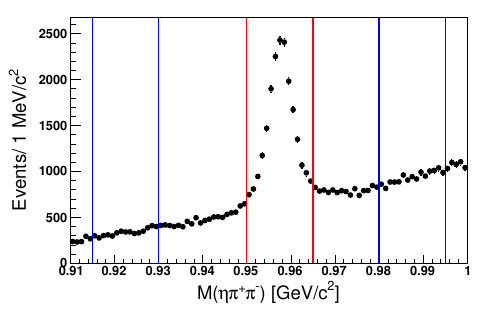
Figure 1 . The invariant mass distribution of ηπ + π − . The region between two red lines is selected as the η 0 signal region, and the regions between two blue lines are the η 0 sidebands.